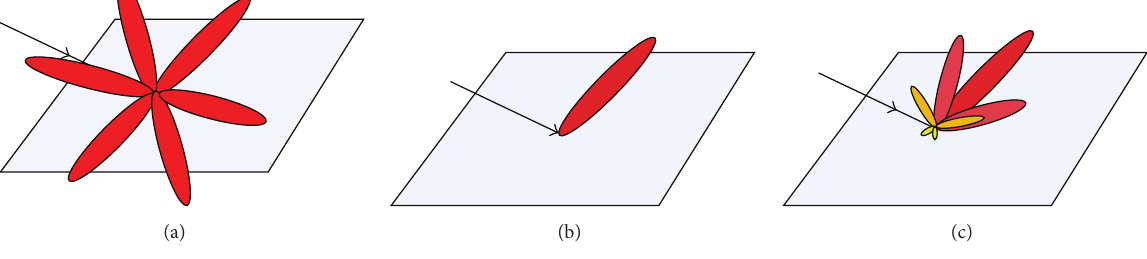
Figure 1: (a) Lambertian model, (b) smooth surface model, and (c) improved